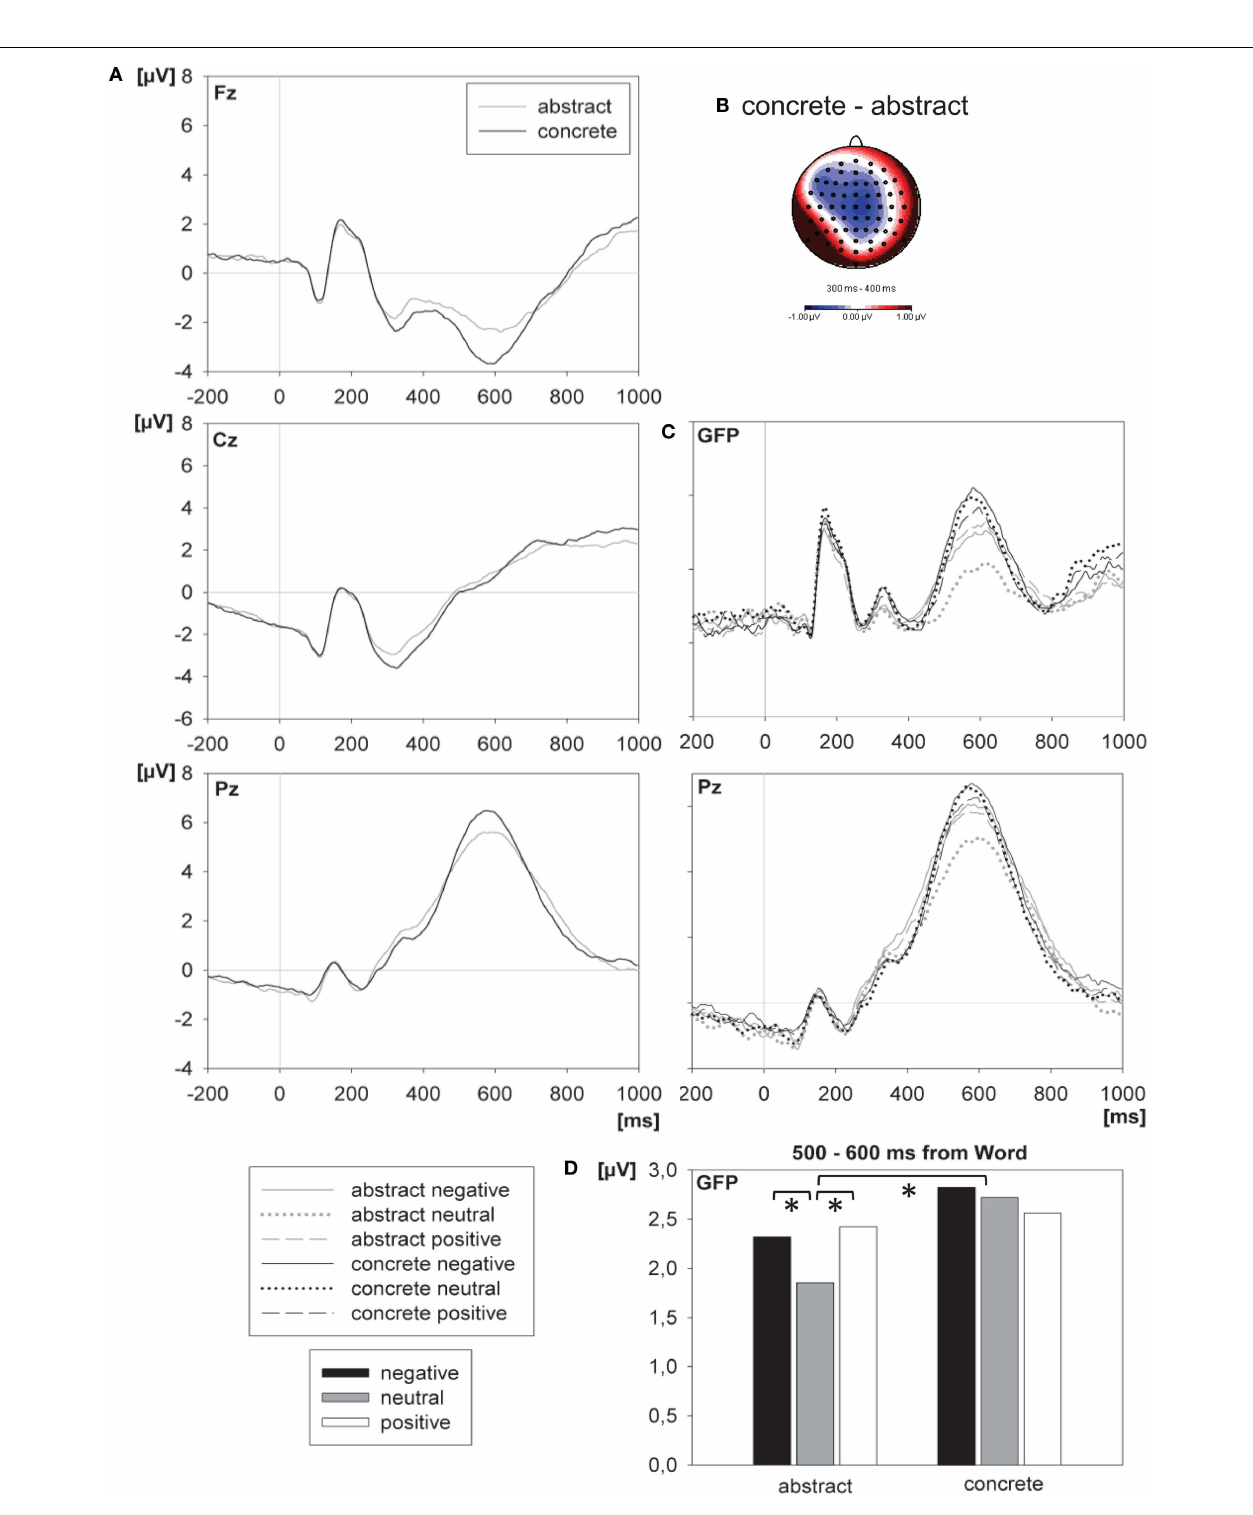
after the word. (C) The middle right panel depicts the grand mean ERP waveforms from GFP and parietal (Pz) electrode, elicited by abstract and concrete words in each valence condition.The word was presented at 0ms. (D) The lower right panel shows the corresponding mean amplitude of the GFP within the 500–600-ms interval after the word. An asterisk marks a significant difference between